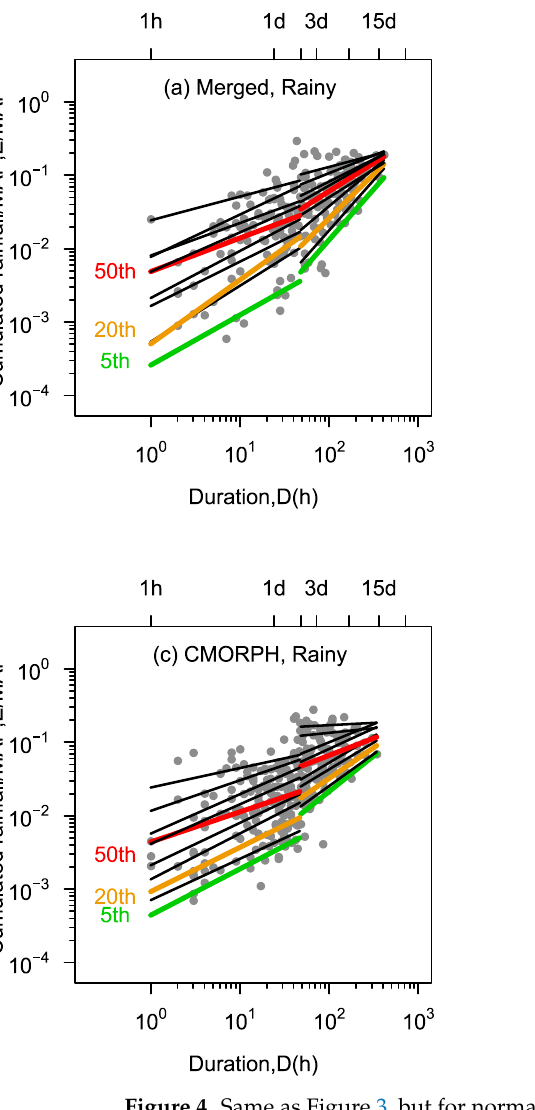
Figure 4. Same as Figure 3, but for normalized E–D thresholds